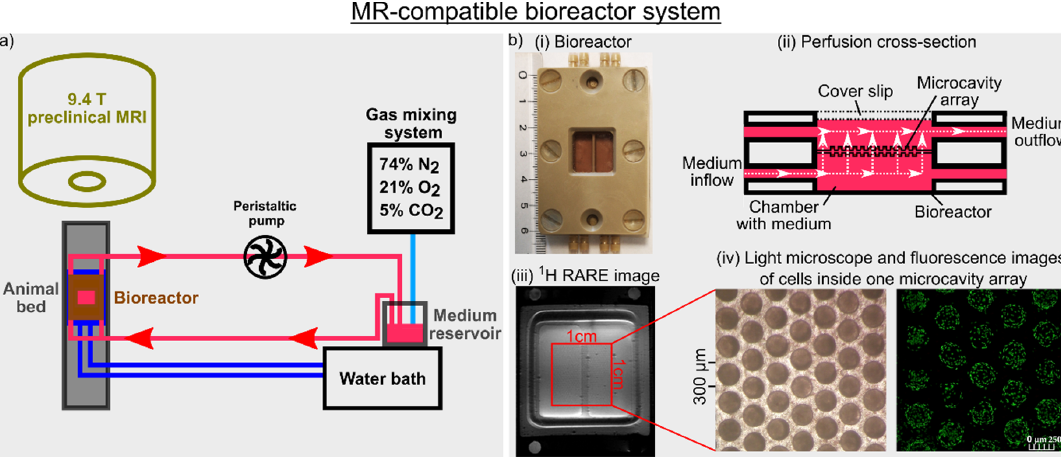
Figure 1. ( a ) Graphical illustration of the magnetic resonance (MR)-compatible bioreactor setup. A peristaltic pump perfused a 3D cell culture at a perfusion speed of 400 μ L/min with fresh medium under normoxic conditions at 37 ◦ C. A change to a new medium was achieved by switching a three-way cock. ( b ) (i) Bioreactor dimension, (ii) cross-section of the bioreactor with perfusion of the medium indicated by white arrows, (iii) 1 H high-resolution rapid acquisition relaxation enhanced (RARE)